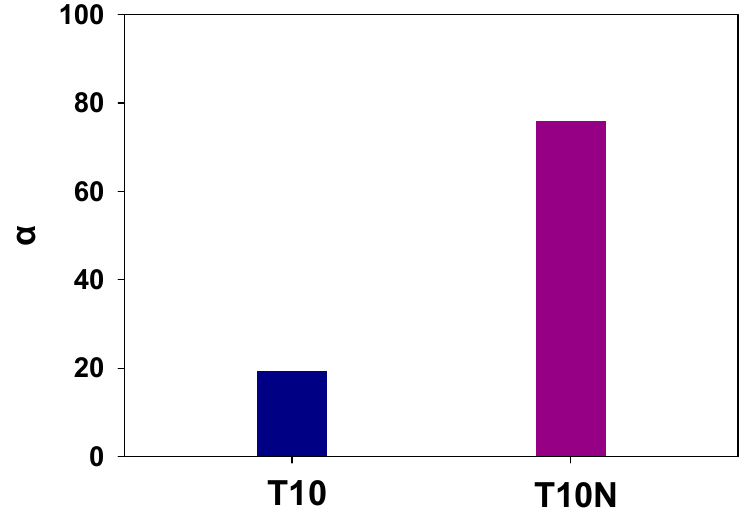
Figure 12. Selectivities of water over DMMP for T10 and T10N.